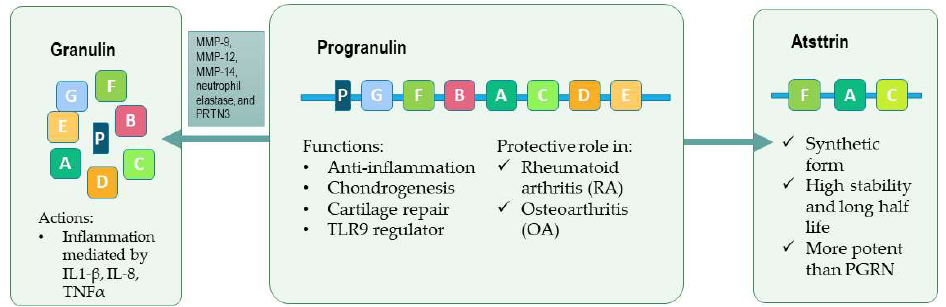
Figure 1. Progranulin (PGRN) structure and its derivative products. PGRN is formed by 7.5 domains of a 12-cysteine motif. Atsttrin is the synthetic form derived from FAC domain of PGRN. Elastase and other enzymes promote PGRN cleavage producing GRN, that promotes inflammation.